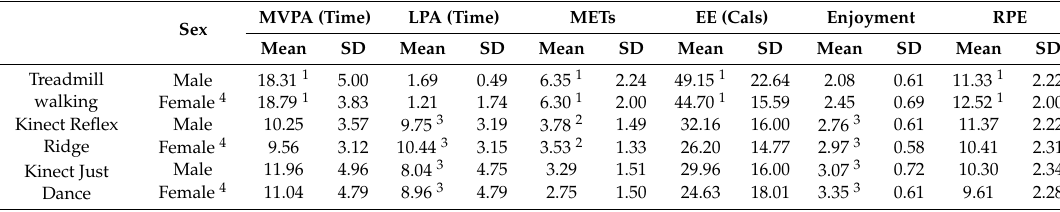
Table 3. Descriptive statistics for outcome variables by